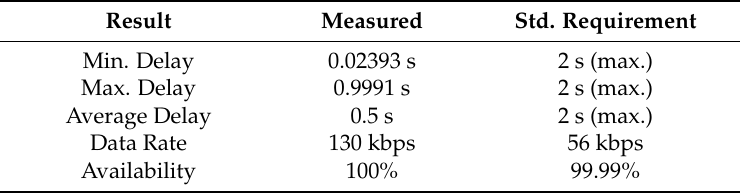
Table 4. The simulation results.